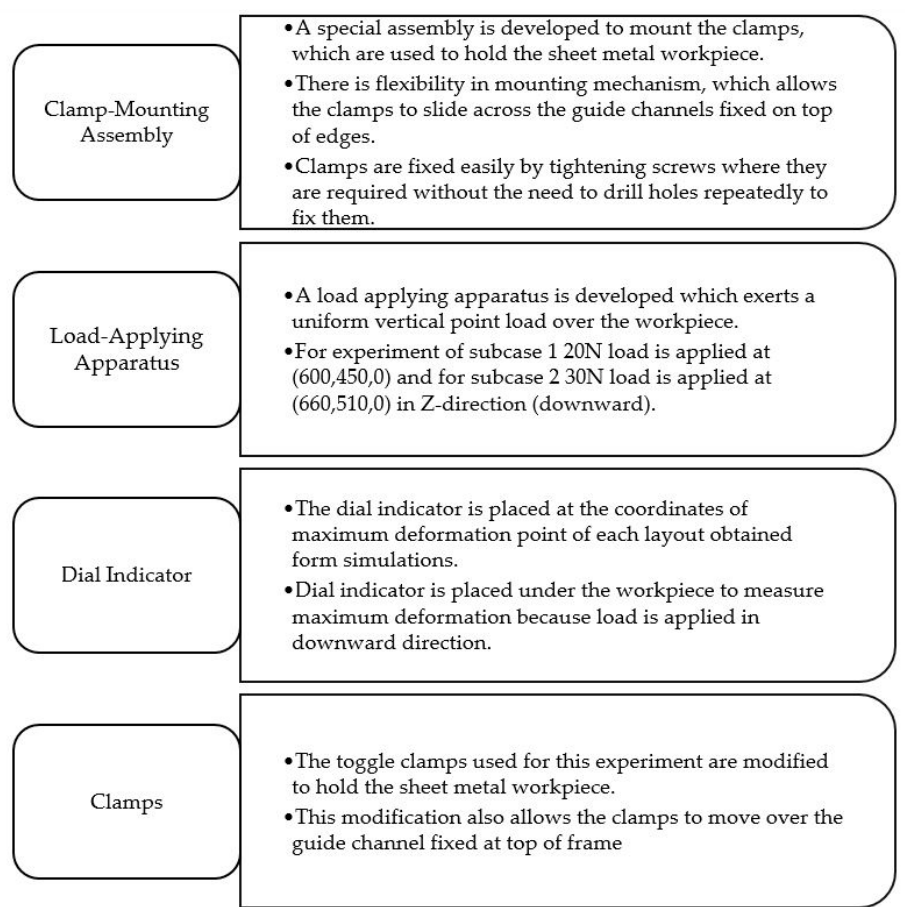
Figure 12. Block diagram containing details of all experimental components. Figure 11. Block diagram containing details of all experimental components. Experimental setup with all its components is shown below in Figure 13. Experimental setup with all its components is shown below in Figure 12.